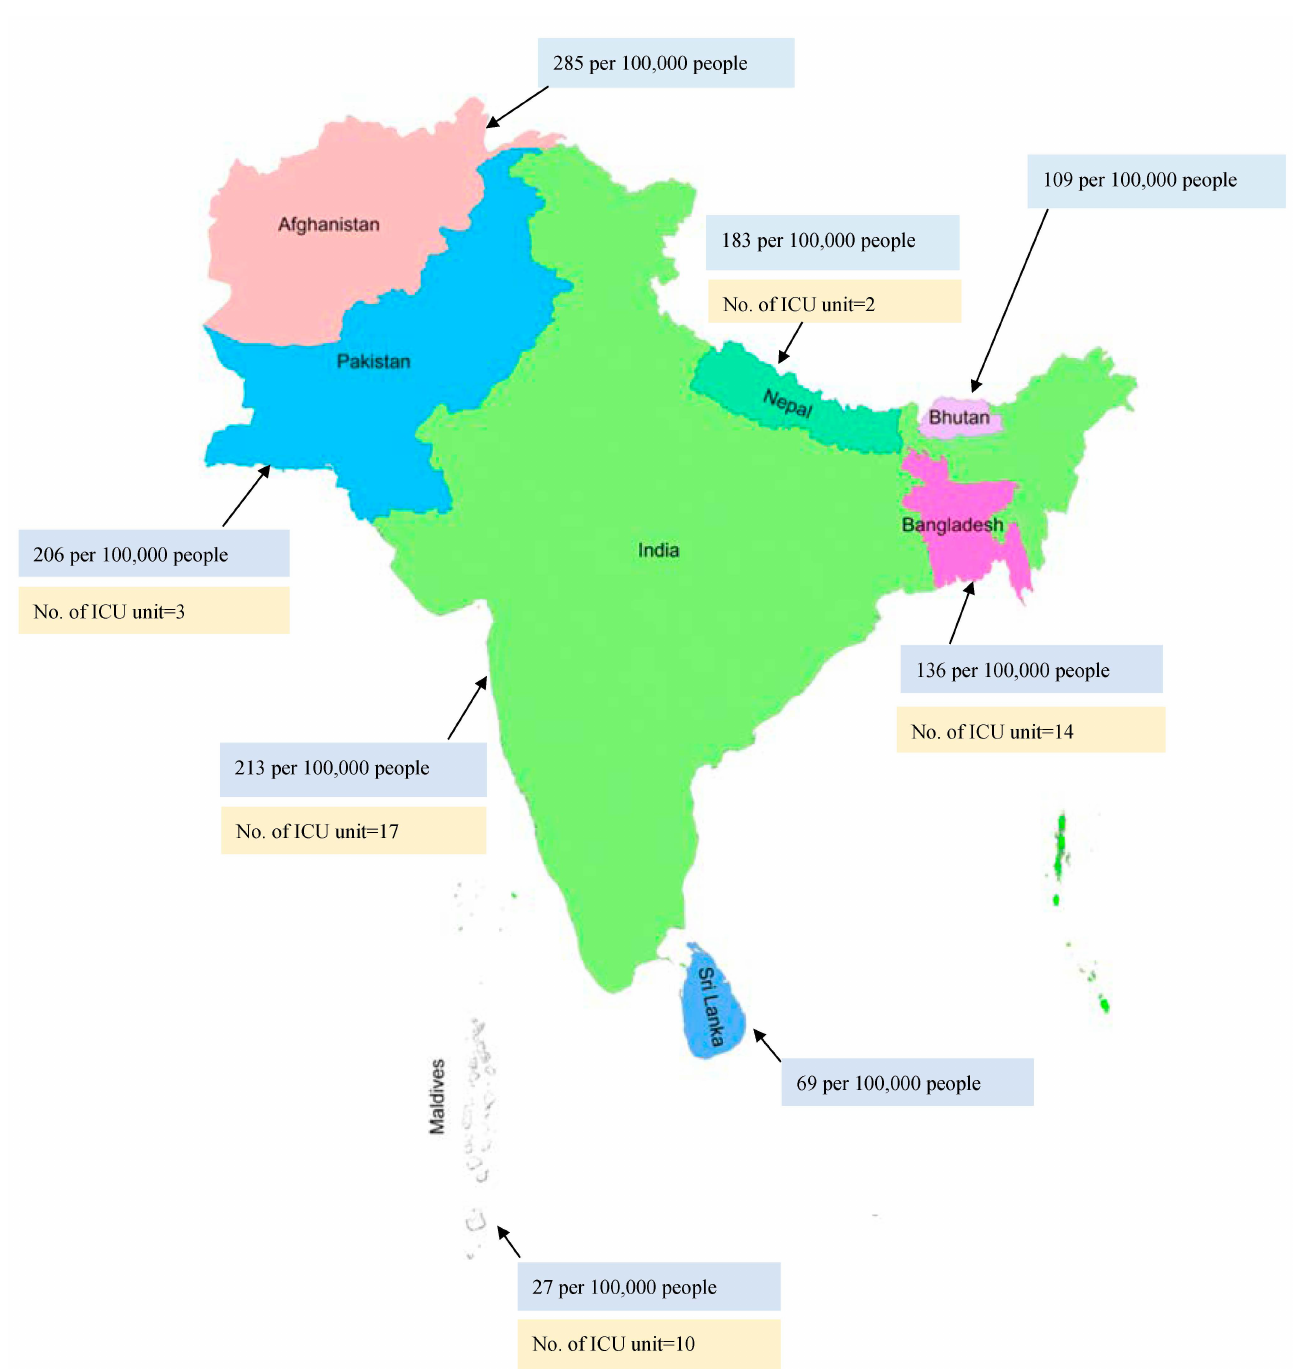
Figure 1. Blue: Mortality rate due to sepsis; Yellow : Prevalence of ICU units in various Southeast Asian